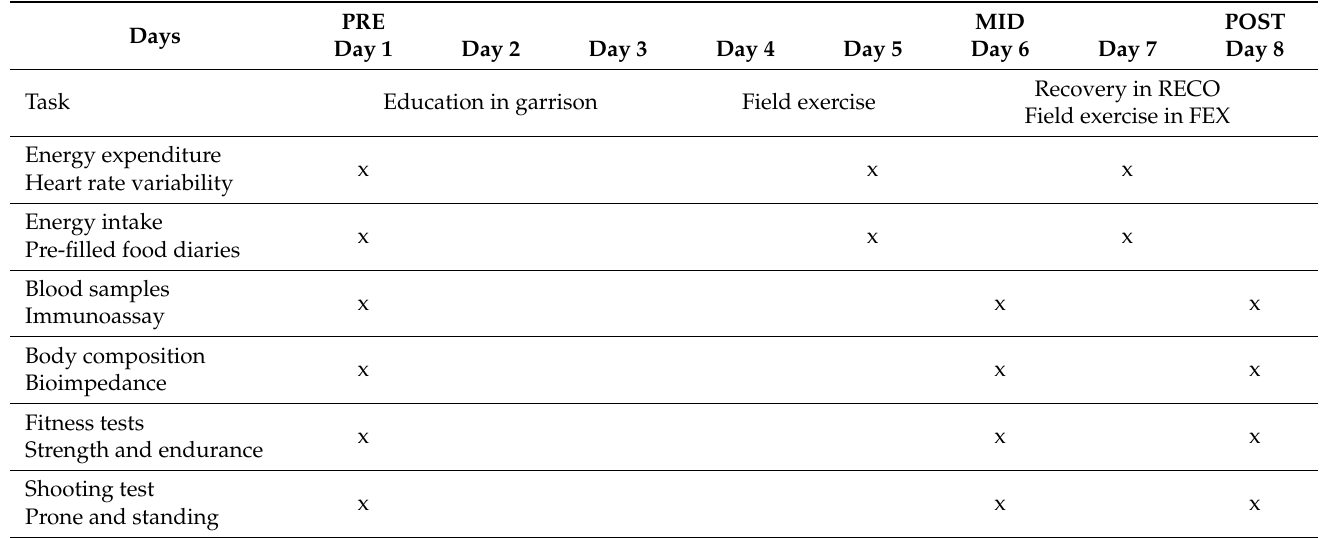
Table 2. Study protocol and the used method for each variable below. x refers to measurement